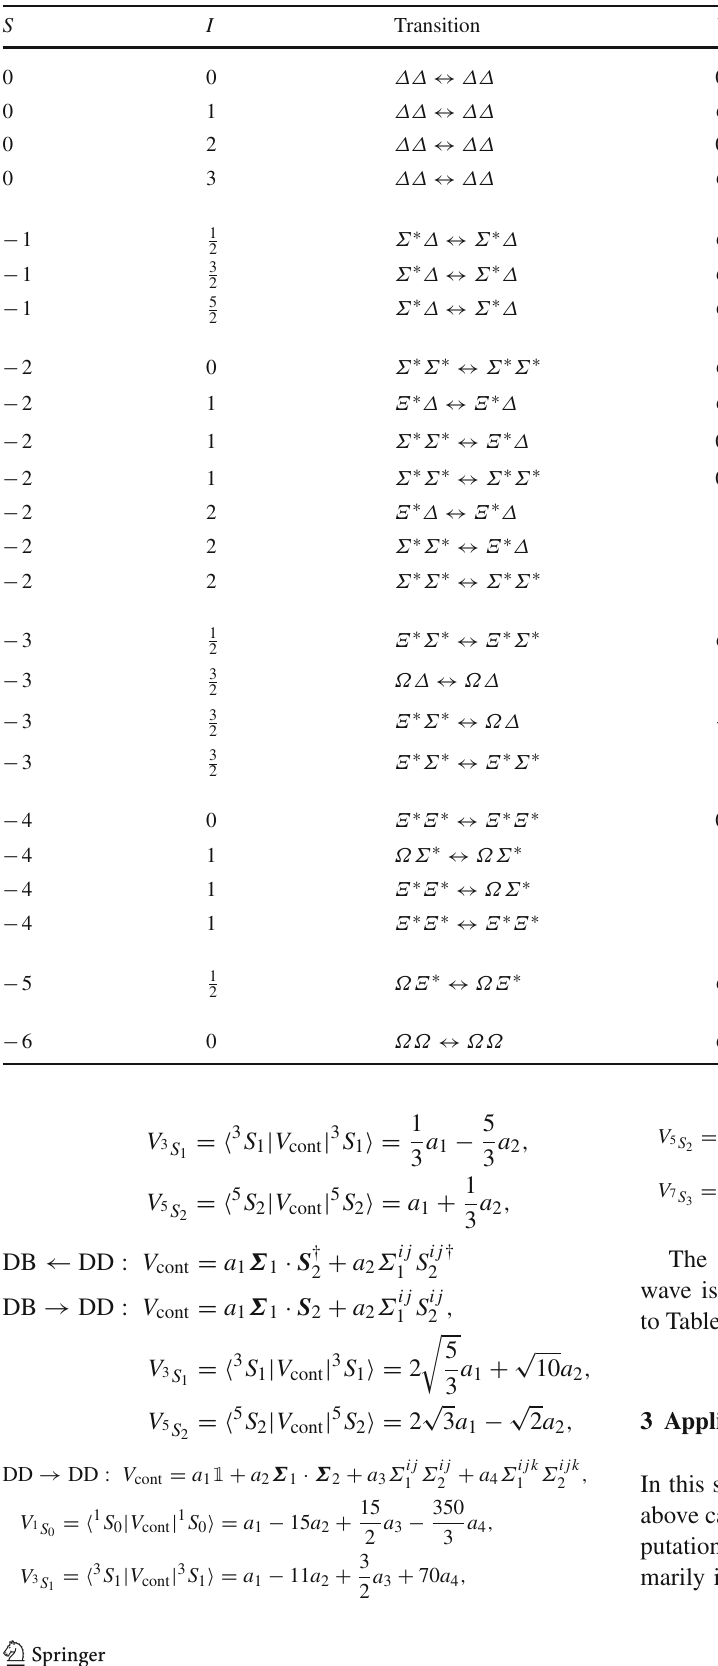
that denotes the BB channel is 22